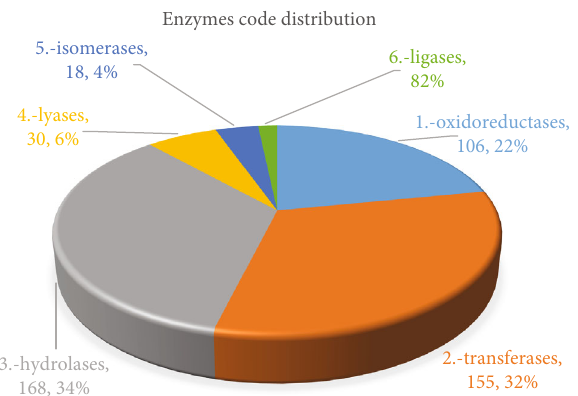
Figure 9: Enzyme code distribution of heat stress-responsive downregulated.